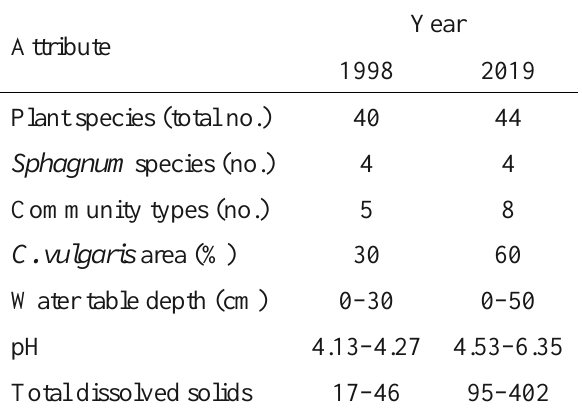
Figure 8. Comparison of the extent of peatlands in 1958 and 2018 within a defined section of the central plateau of Terceira Island drawn in ArcGIS 10.6.1, based on historical aerial photos. Table 4. Comparison of some attributes of the Criação do Filipe peatland complex between surveys 21 years apart. Data from Mendes (1998) and this study